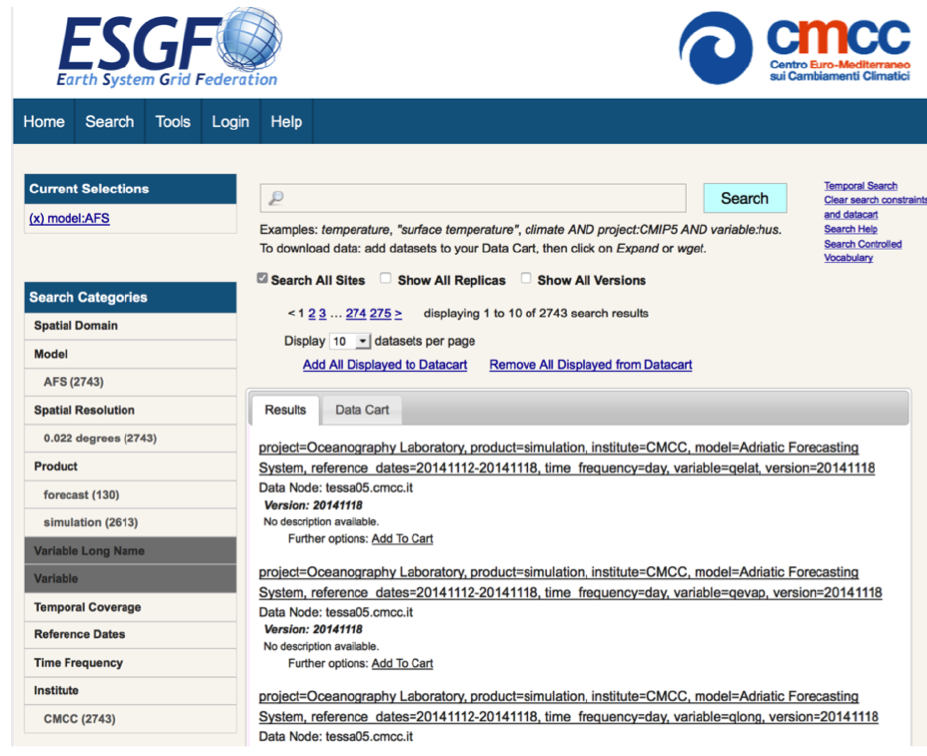
Figure 5. List of facets for AFS products as published in the ESGF data node for TESSA.